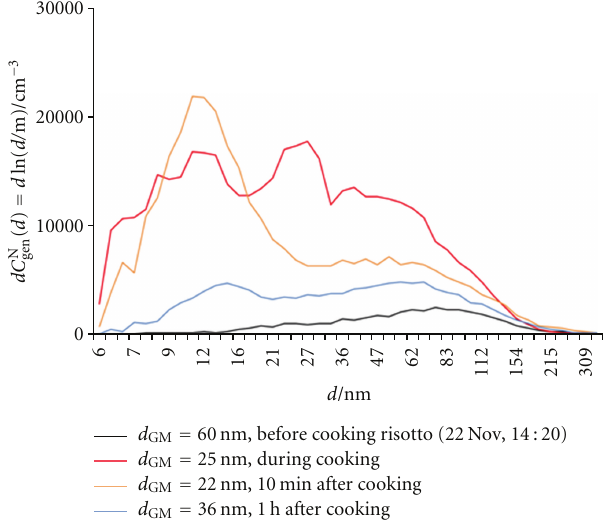
Figure 18: Number size distributions (d C N “risotto”